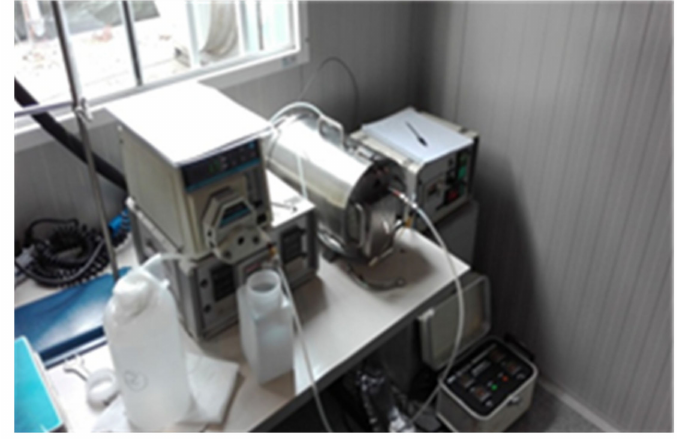
Figure 2. The butanol vaporisation